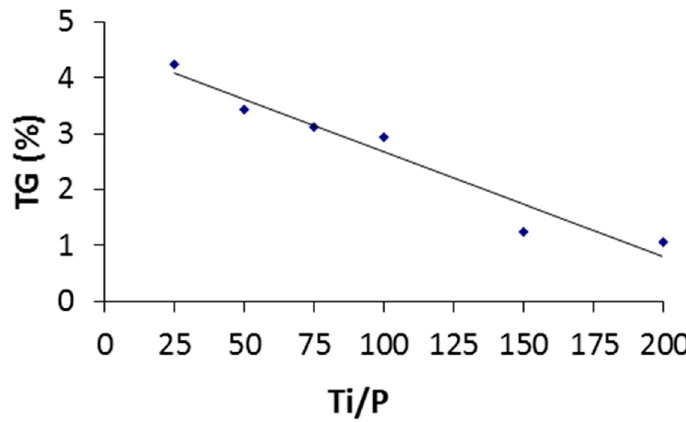
Figure 4. Variation of organic weight loss in the range of 300–500 ◦ C in thermogravimetric analysis as a function of the starting Ti/P